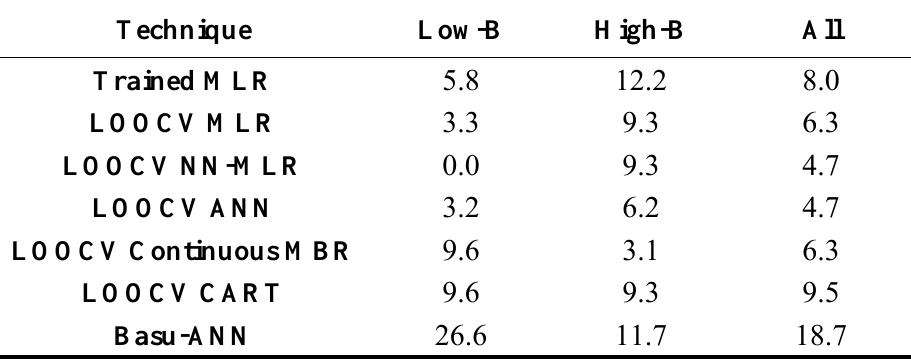
Table 2. Percent Misclassification derived from continuous